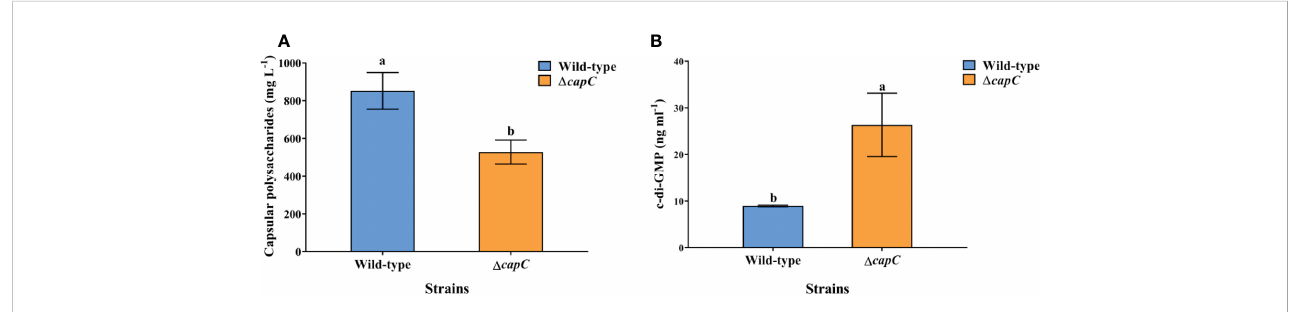
FIGURE 5 Difference in CPS secretion (A) and c-di-GMP (B) of experimental strains.